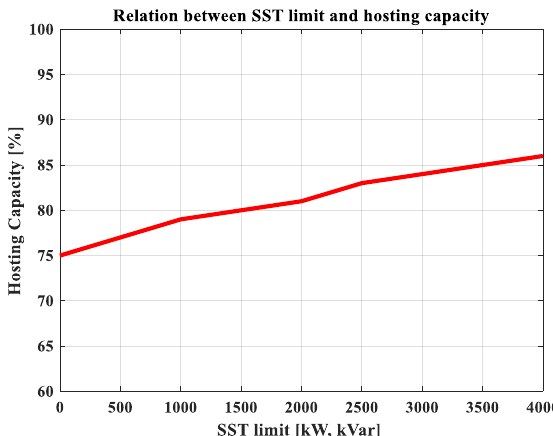
Figure 11. Relation between the SST limit and the hosting capacity . Table 3. Probability of violation for each case.